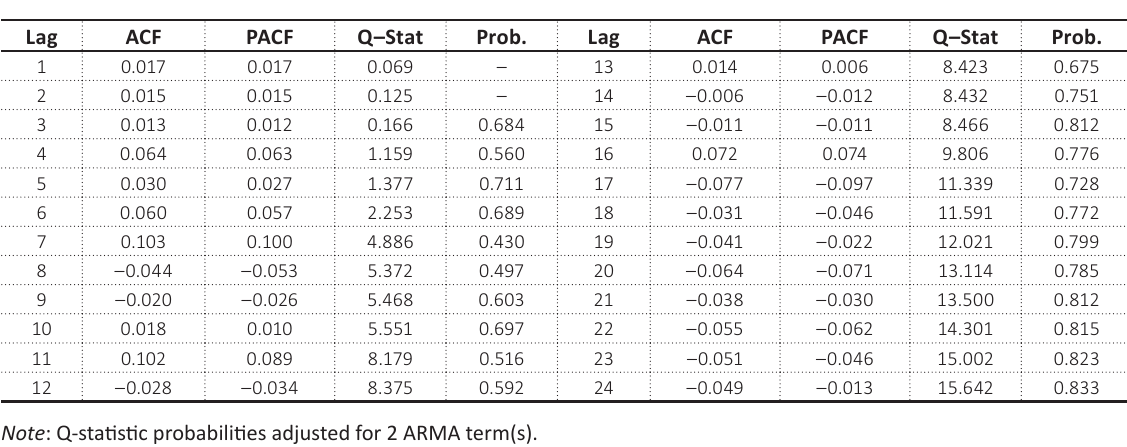
Table A4. Squared residuals’ ACF for (5-6) model